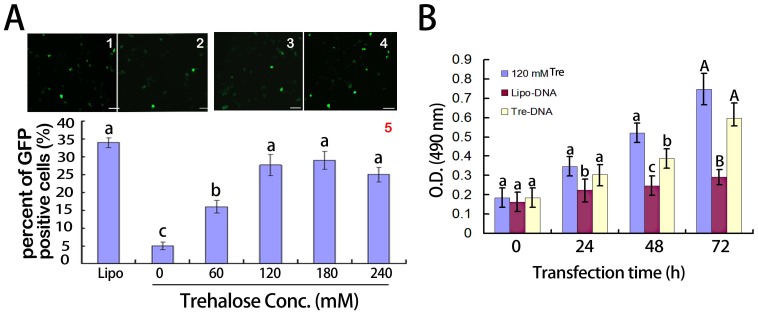
Effects of trehalose on transfer of pEGFP-C1 into the epididymal epithelial cells in vitro.A) EGFP positive cells were determined at 72 h after transfection. 1) The green fluorescent cells transfected pEGFP-C1 with lipofectamine 2000; 2) The morphology of cells transfected pEGFP-C1 without lipofectamine 2000 or trehalose; 3) The morphology of cells transfected pEGFP-C1 with 60 mM trehalose; 4) The morphology of cells transfected pEGFP-C1 with 180 mM trehalose; 5) The percent of GFP positive cells was determined by flow cytometry. Lipo represents complex of lipofectamine 2000 and DNA; 0, 60, 120, 180, and 240 represent the complex of different concentration trehalose and DNA, respectively. Different letters indicated significant difference (p<0.05), means±S.D, n = 5. B) Effect of 180 mM trehalose-DNA on proliferation of the cells by MTT analysis as described in Materials and Methods. The cells were cultured in the medium with 120 mM trehalose as a control. Lipo-DNA represented the transfection cells with the complex of lipofectamine-2000 and DNA; DNA-Tre indicated that the transfection cells with the complex of 180 mM trehalose and DNA; 120 mM Tre represented control; Different letters (a, b, c) indicated significant differences (p<0.05); and A, B indicated highly significant differences (p<0.01). Bars represent means±S.D, n = 5.